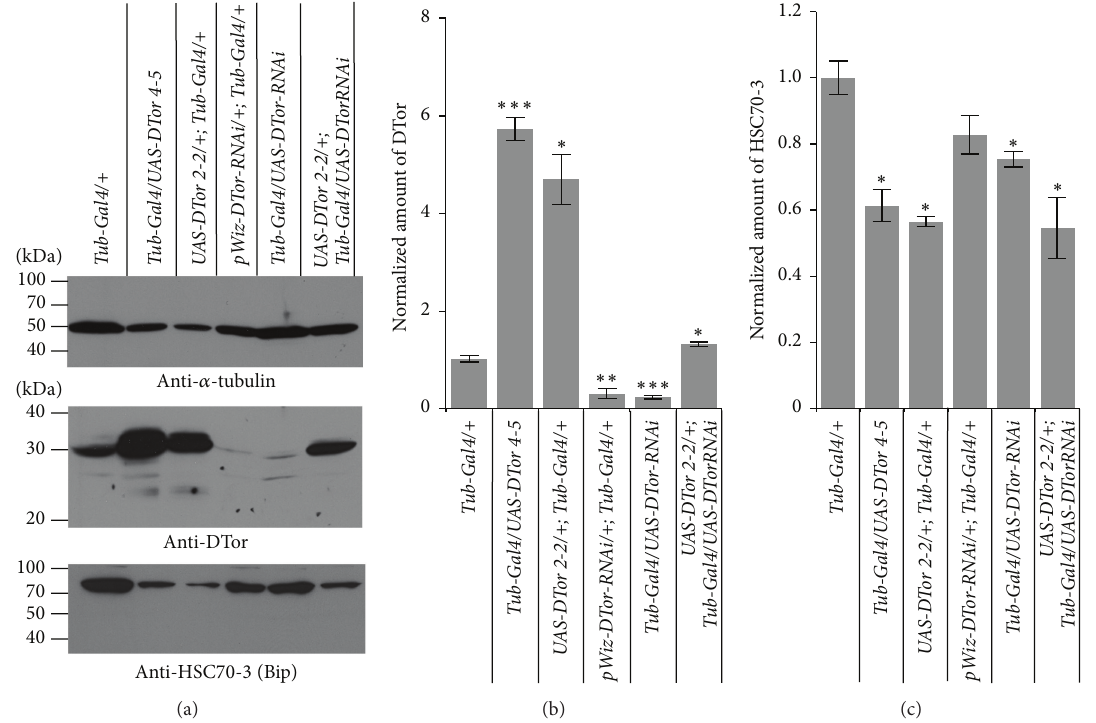
Figure 1: The altered expression levels of Drosophila Torsin protein in transgenic flies. (a) The western blots of various strains expressing UAS- DTor-cDNA, pWiz- or UAS-DTor-RNAi , or both of UAS-DTor-cDNA and UAS-DTor-RNAi in all tissues using Tub-Gal4 drivers. UAS-DTor lines increased expression of DTor compared to that of genetic background (Tub-Gal4/+). Expressing two independent DTor-RNAi lines using Tub-Gal4 drivers induced significantly reduced DTor. At least 2 different sizes of DTor bands were detected from genetic backgrounds and flies expressing DTor-RNAi. However, 1 or 2 additional bands were detected from UAS-DTor overexpressing lines. The expression of the Drosophila homologue of Bip and heat shock 70-kDa cognate protein 70-3 (HSC70-3) was reduced in most transgenic flies compared with that of controls. (b) Quantification of the normalized amount of DTor in various strains. Two UAS-DTor-cDNA lines had significantly increased expression levels compared to those of Tub-Gal4/+. In contrast, the expression of DTor proteins was downregulated when two independent double-stranded RNA inhibitory constructs for DTor were expressed by Tub-Gal4 promoters. Simultaneous expression of both DTor-cDNA and DTor-RNAi constructs produced DTor expression levels approximately 1.5 times higher than those of genetic back ground (Tub-Gal4/+). (c) The expression of HSC70-3 (Bip) was significantly reduced in all transgenic fly, except one expressing pWIZ-DTor-RNAi . ∗ 𝑝 < 0.05 , ∗∗ 𝑝 < 0.01 , and ∗∗∗ 𝑝 < 0.005